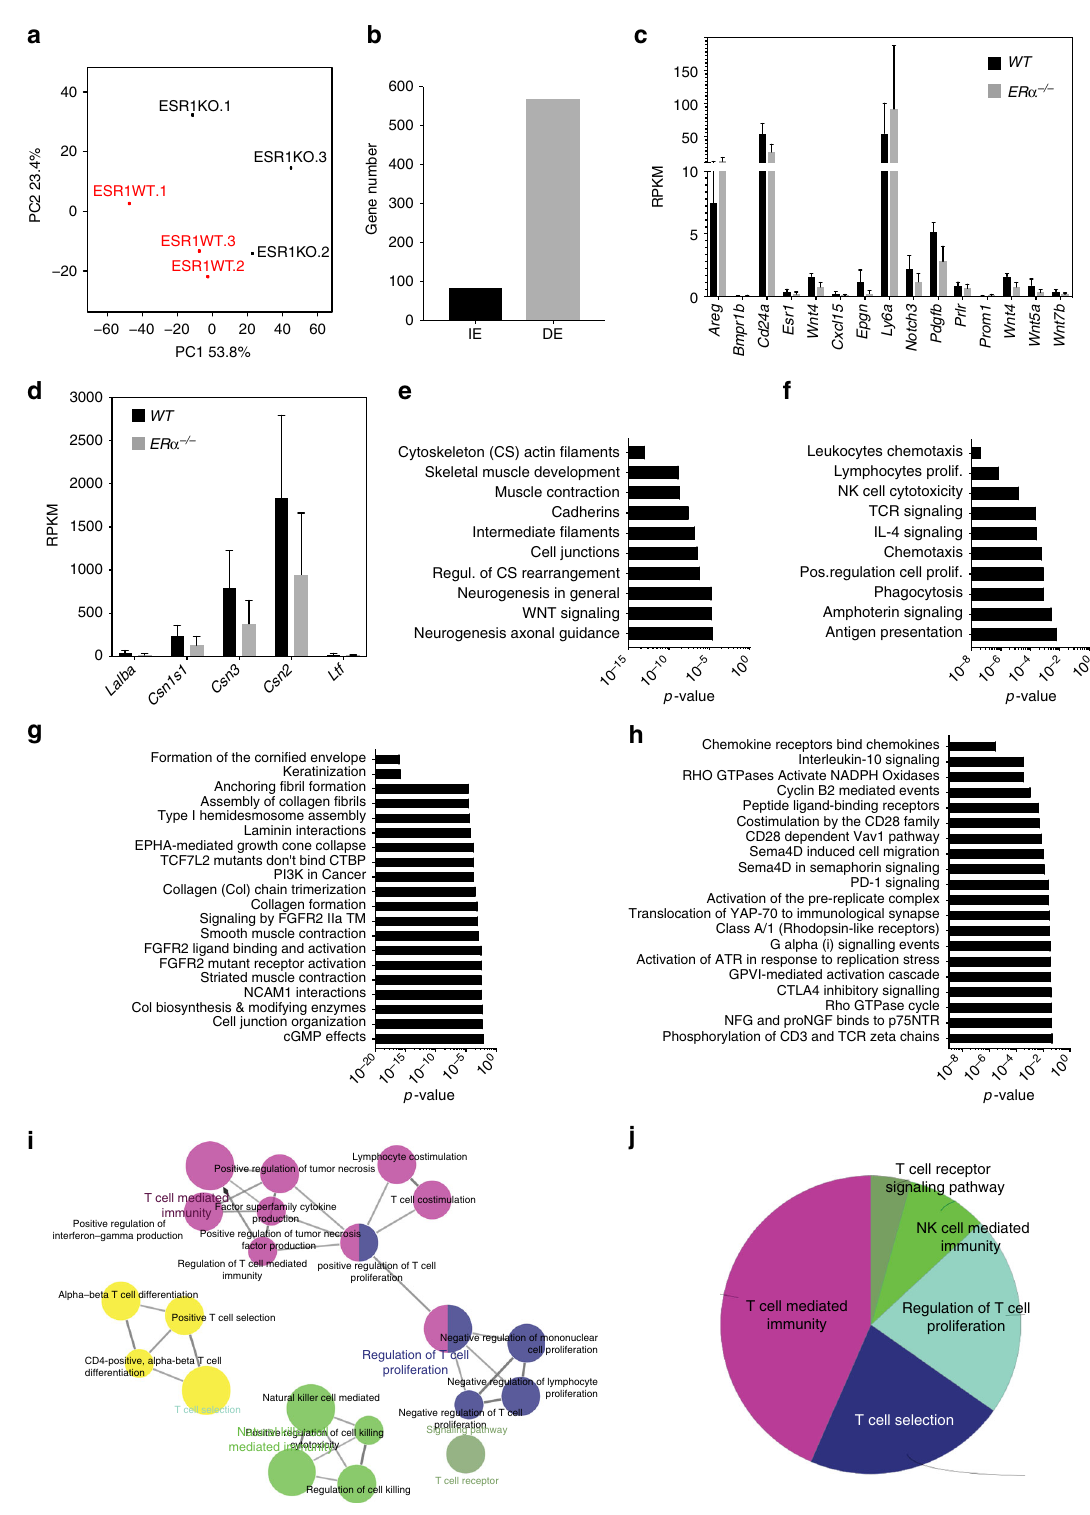
curated gene sets a mammary stem cell signature scored highest with p = 8E105 (Fig. 8b, c). Thus, ER α expression is not required for milk gene expression but is important for the transcriptional control of mammary stem/progenitor cell function as well as cellular